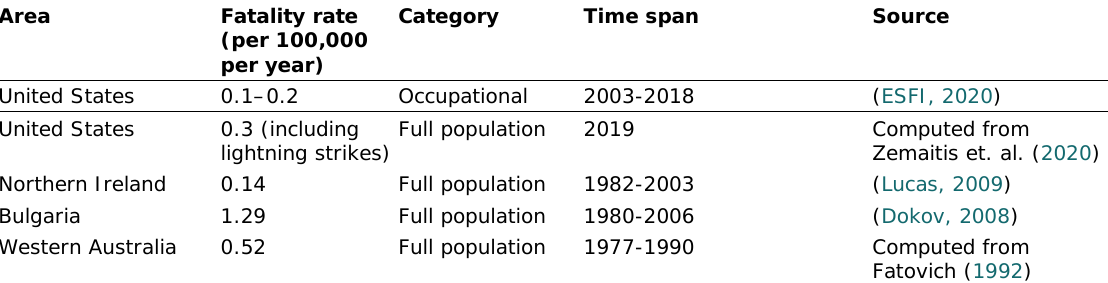
Table 1. Electrical accident fatality rates from